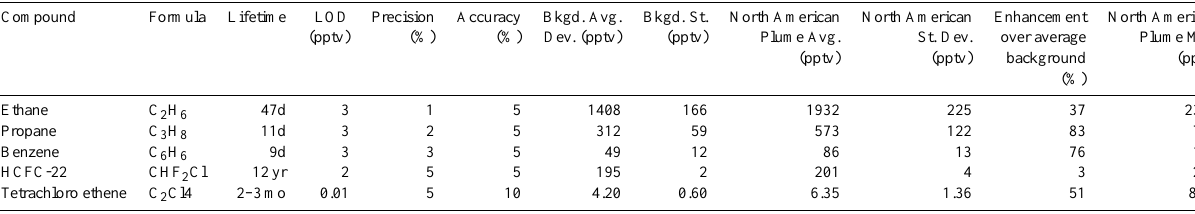
Table 3. As in Table 2, but for the North American plume.